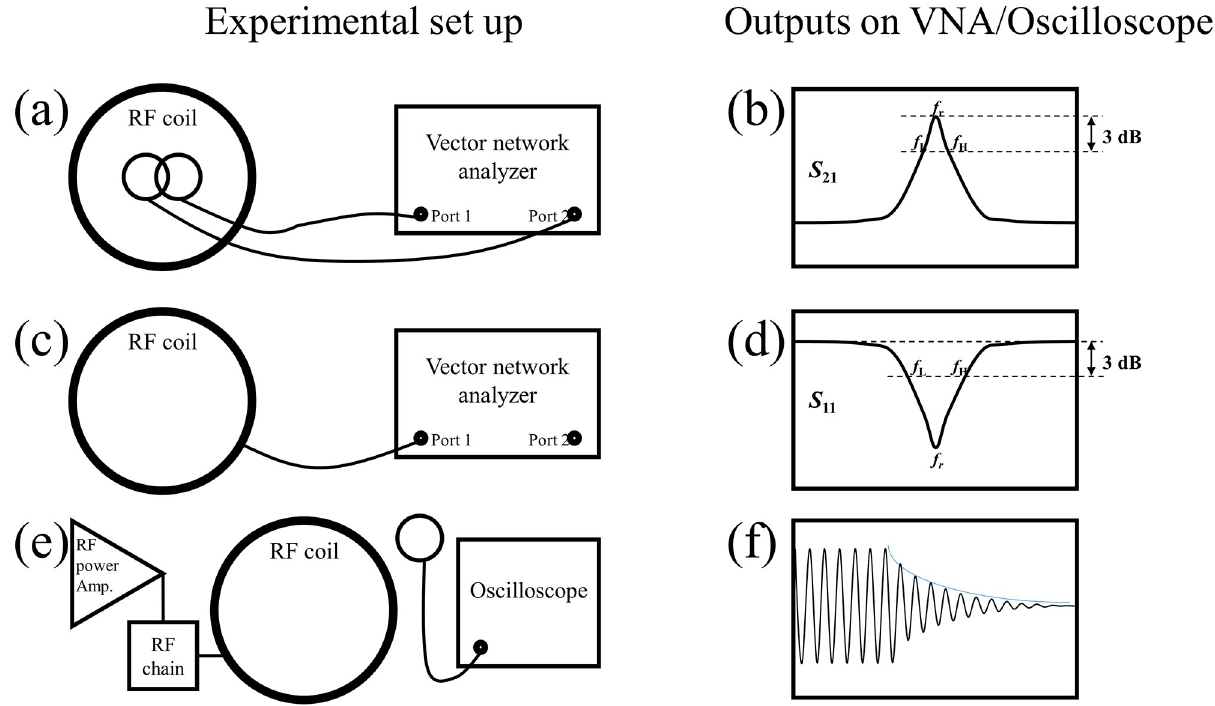
Fig 4. Three different methods for measuring Q -factor. (a) Diagram using two decoupled sniffer loops and (b) example insertion loss between two sniffer loops. (c) Diagram to measure return loss of the RF coil and (d) example return loss of the RF coil. (e) Diagram to measure ring-down time and (f) example waveform of the applied RF